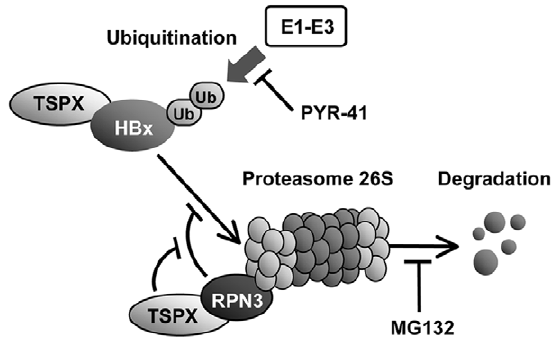
Figure 5. A model illustrating the potential roles of TSPX and RPN3 as regulators of ubiquitin-proteasome dependent HBx degradation. TSPX enhances the HBx degradation by recruiting HBx to proteasome complex, and inhibiting the protective function of PRN3 on HBx-degradation. E1-E3 indicates the ubiquitylation cascade including E1, E2, and E3 enzymes. MG132-responsive and PYR-41- responsive sites are also indicated.